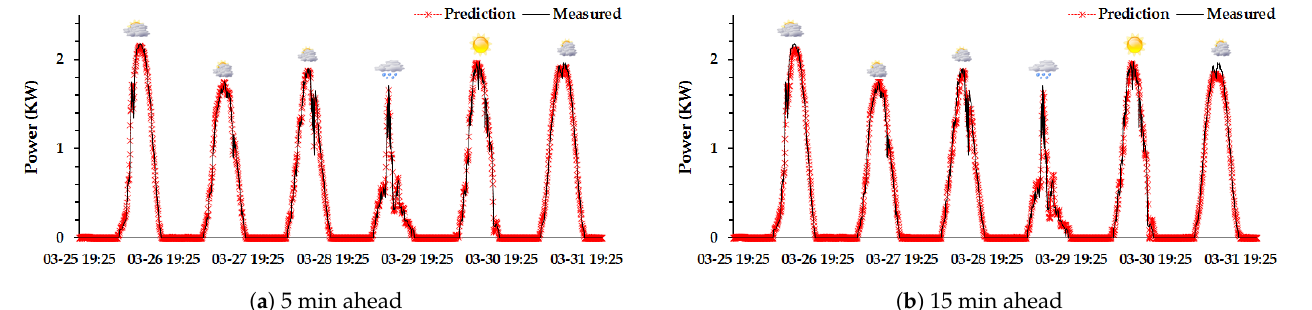
Figure 11. The very short-term forecast results for 6 consecutive days (RNN layers = 3, time steps = 12). For the short-term PV power generation forecast, the weather change during the longer period should be observed, since it will be related to the PV power generation trend during a half-day or a full day. In the experiments, it was predicted based on data collected during 6, 12, 18, or 24 h. For the short-term forecast, the sampling interval between two time-steps in RNN was a half hour (30 min) or one hour. If the samples every 5 min were used, the number of time-steps in RNN increased too large to degrade the overall prediction accuracy and to increase the training time. Table 6 showed the forecast error of the short-term PV power generation according to the sampling interval, time-steps, and layers of RNN. As shown in Table 6, the model that had 3 RNN layers, 12-time steps in RNN, and the sampling interval with an hour achieved the minimized prediction